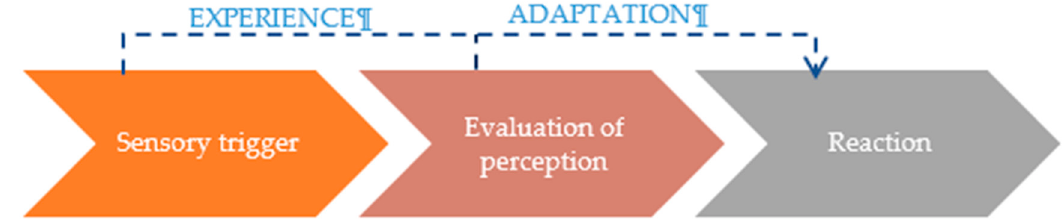
Figure 6. The processing of sensory triggers and subsequent human response.